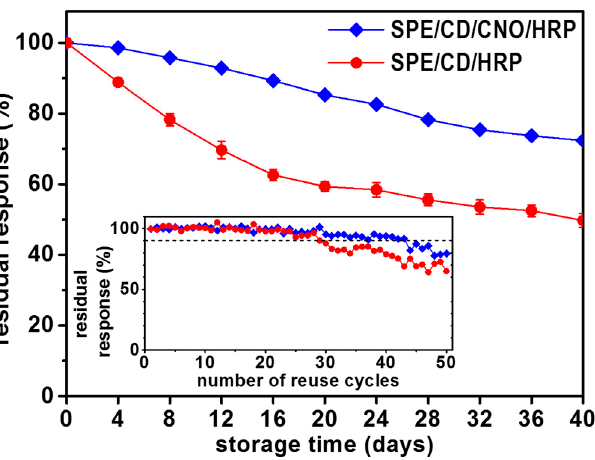
Figure 8. Storage stability and reuse cycles (inset) of SPE/CD/CNO/HRP and SPE/CD/HRP biosensors.